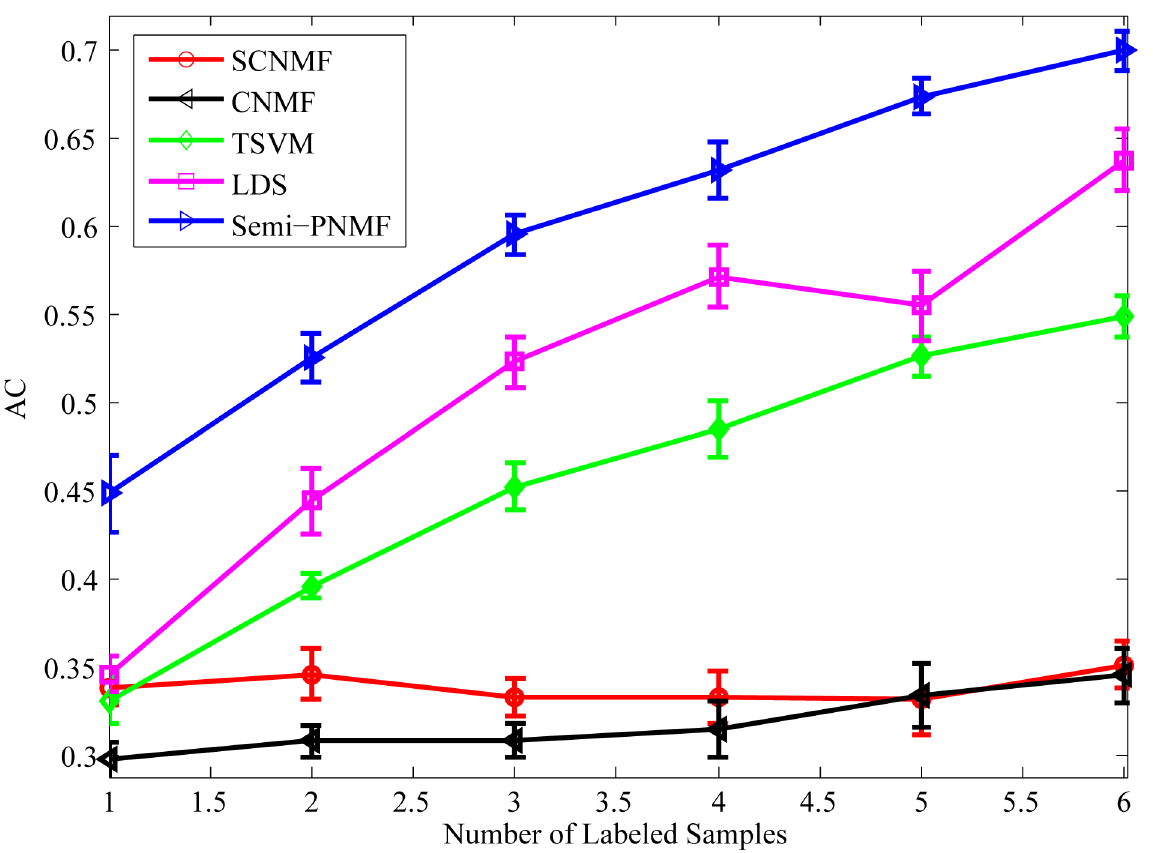
Fig 8. Average accuracies versus different numbers (1 – 6) of the labeled samples for each class of the GCM